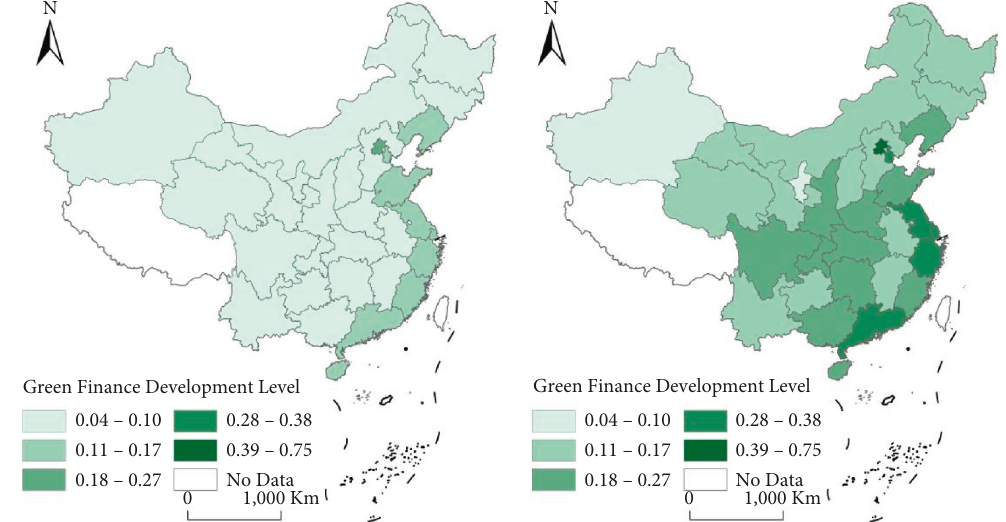
Figure 1: Green finance development level in 2005 and Table 2: Benchmark regression results.